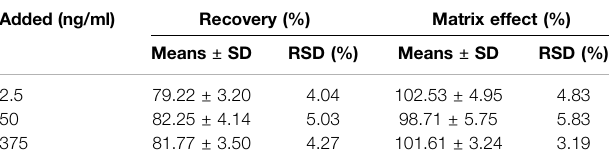
TABLE 2 | Results of recovery and matrix effect of erda fi tinib ( n (cid:2) 6). Added (ng/ml)